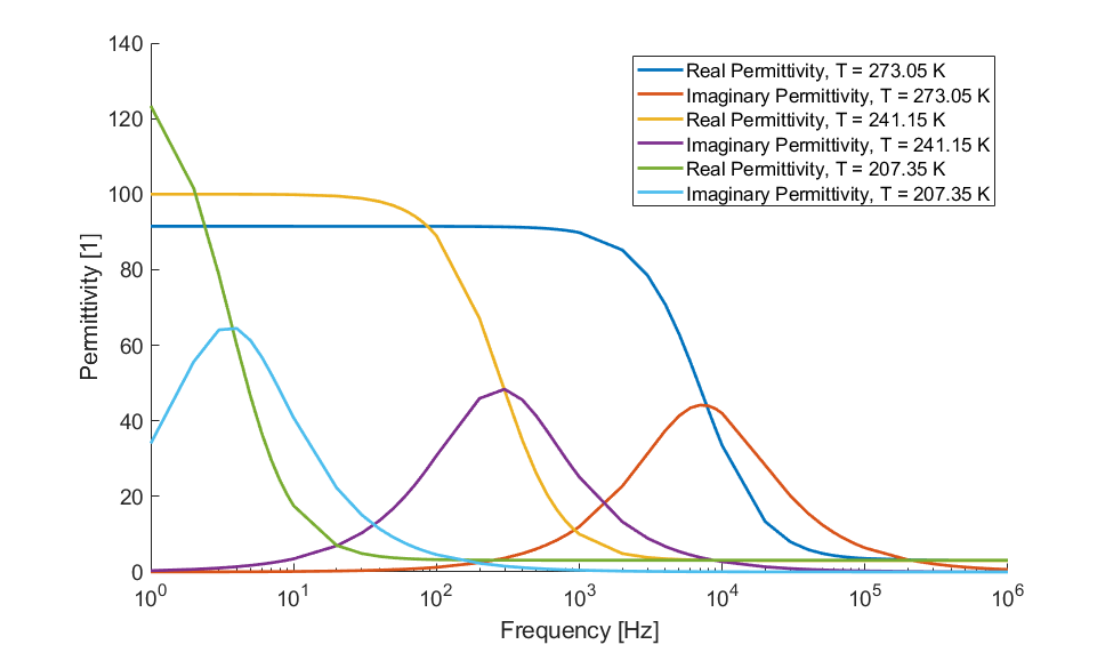
Figure 1. Permittivity dependency on frequency and temperature